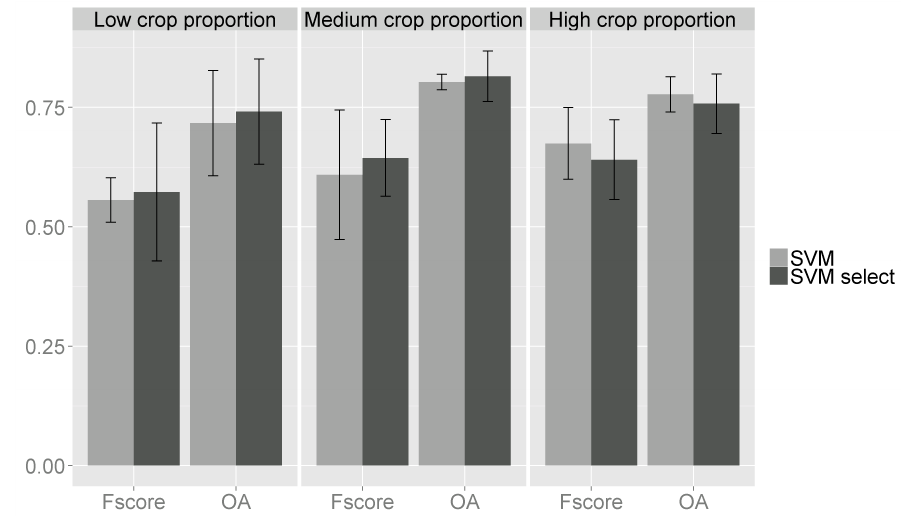
Figure 10. Comparison of the accuracy for SVM classification with all features (SVM) and selected features (SVM select). The whiskers represent the standard deviation of the five selected grid cells for each crop proportion